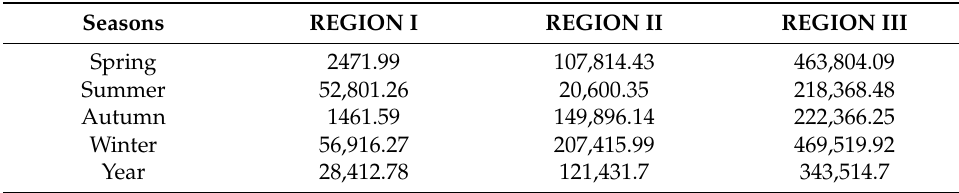
Table 2. The CH 4 emissions carried by air-mass back-trajectories in three regions across China in 2007 from EDGAR * (10 3